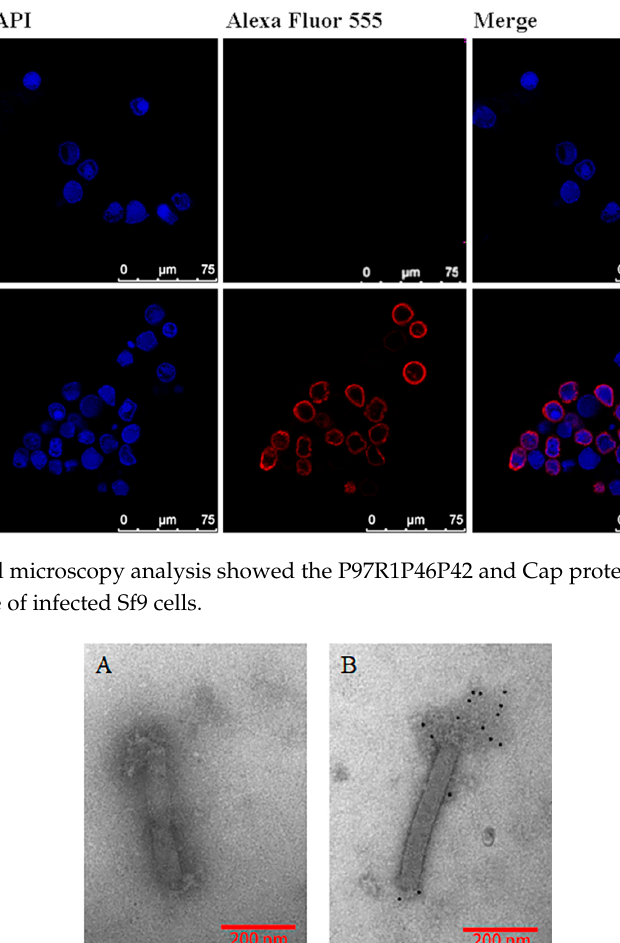
Figure 3. Visualization using mCherry and EGFP fluorescent proteins of rvAc-P97R1P46P42-mCherry-Cap-EGFP-infected Sf9 cells; both of the antigens can be produced by the recombinant baculovirus.